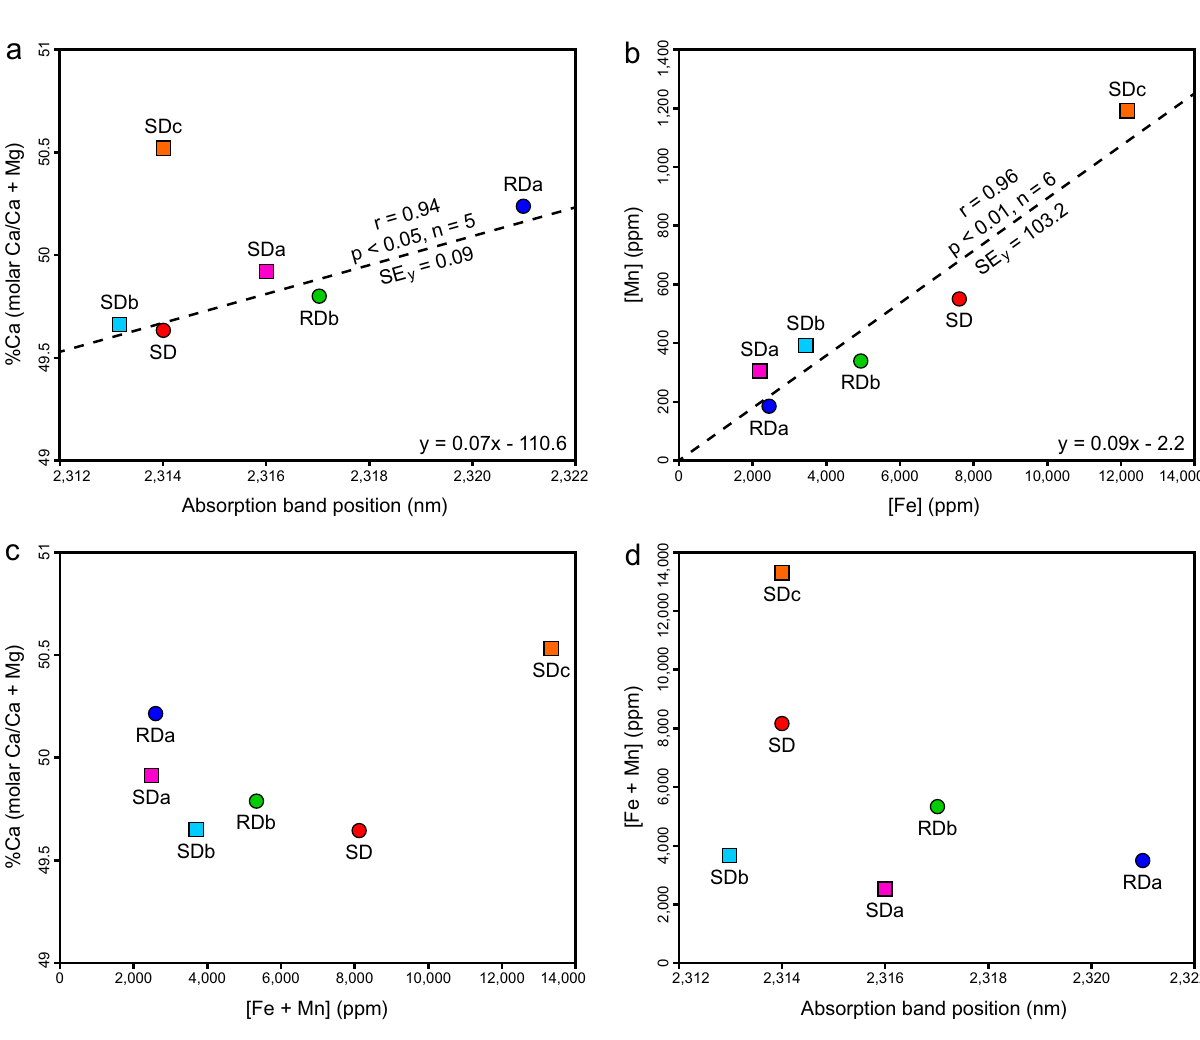
Figure 6. Scatterplots showing the relationships between: ( a ) %Ca versus the position of the ~ 2315 nm absorption-band, ( b ) the [Mn] versus the [Fe], ( c ) %Ca versus the [Mn + Fe], and ( d ) the [Mn + Fe] versus the position of the ~ 2315 nm absorption-band. r = correlation coefficient. SEy = standard error of the y-estimate. Note that the r and SEy for ( a ) omit